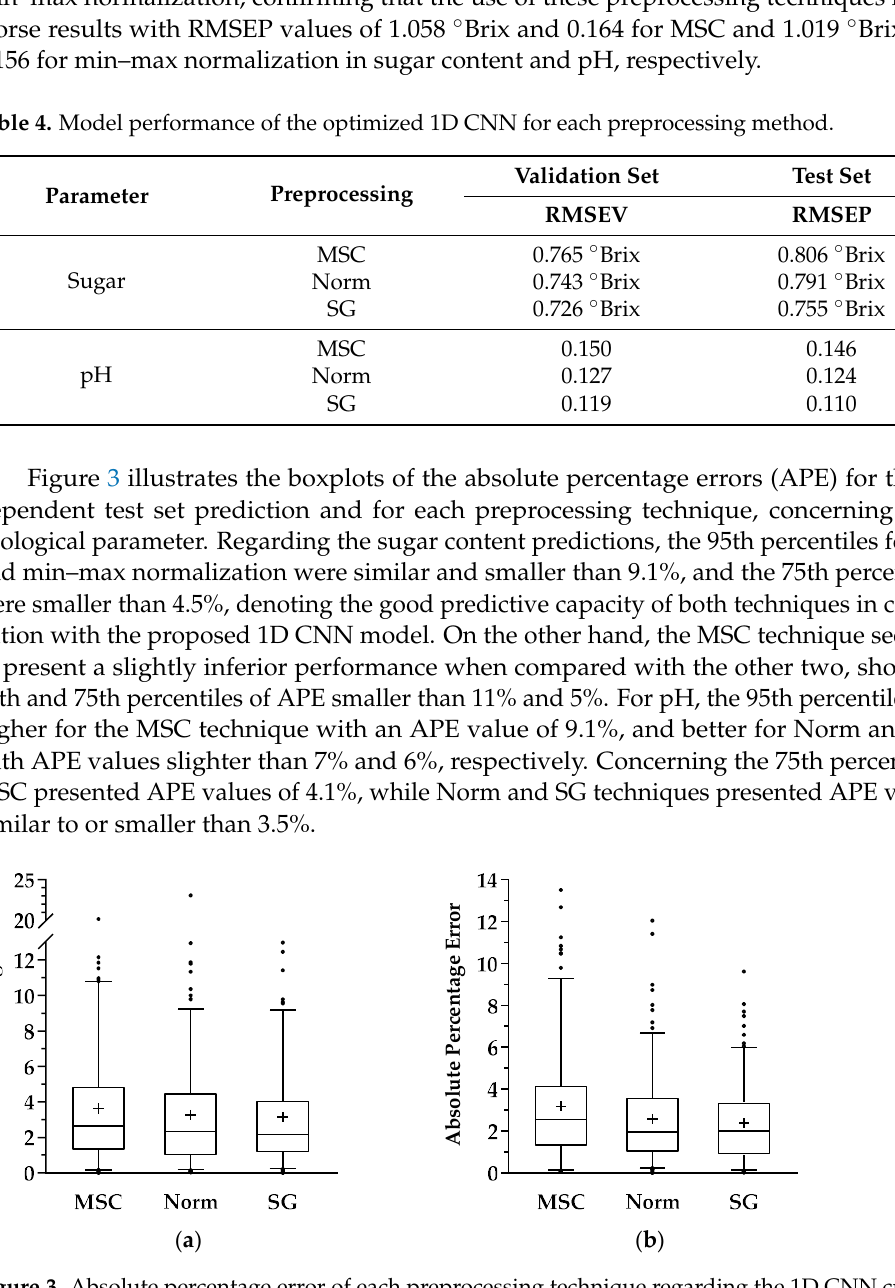
Figure 3. Absolute percentage error of each preprocessing technique regarding the 1D CNN created when applied to independent test samples for ( a ) sugar measurements and ( b ) pH measurements.